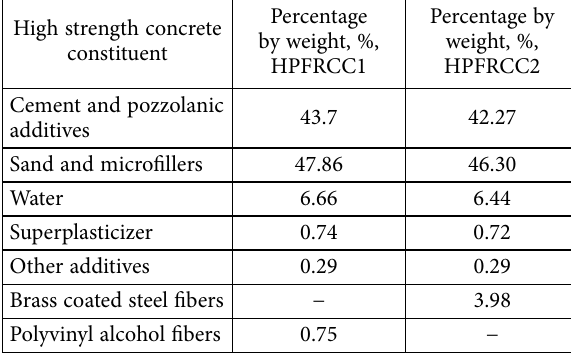
Table 2. Composition of high strength